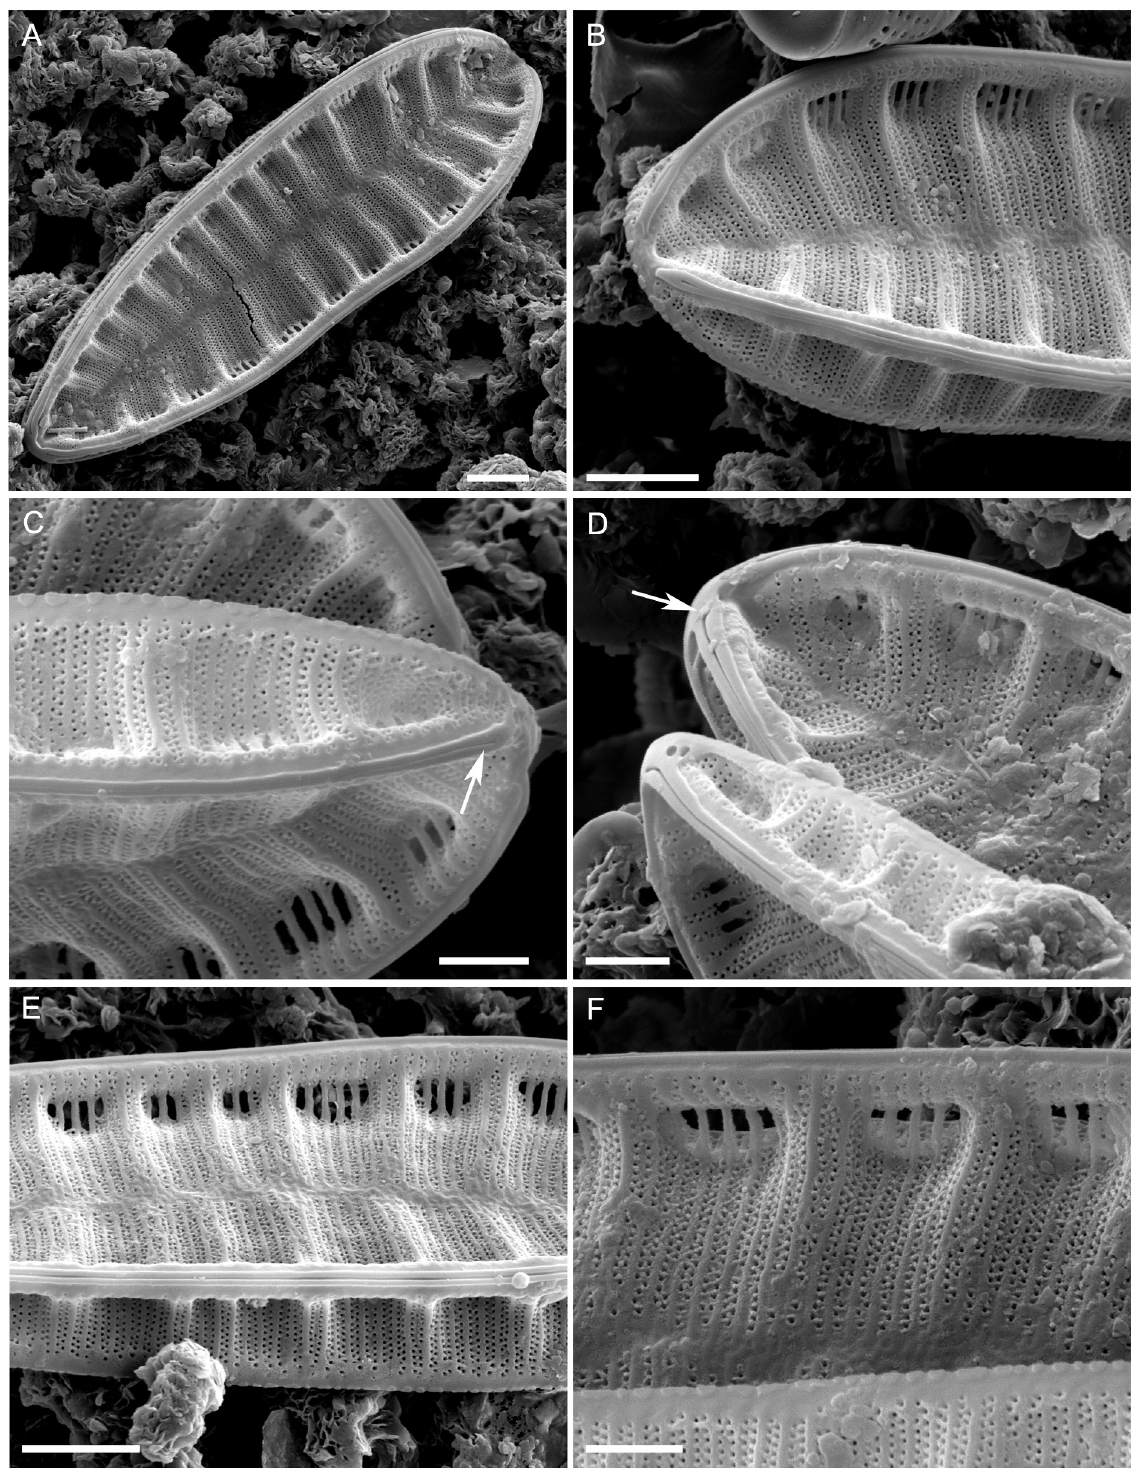
Fig. 8. Surirella congolensis sp. nov., type material from sample CCA 2071, Lomami River, DR Congo, SEM. External view. A . Overview. B–C . Detail of foot pole showing the straight not expanded raphe endings (arrow). D . Detail of the apical pole showing the slightly curved raphe endings (arrow). E–F . Detail of the biseriate striae and the open fenestrae with the fenestral bars. Scale bars: A–B = 2 µm; C–F = 1